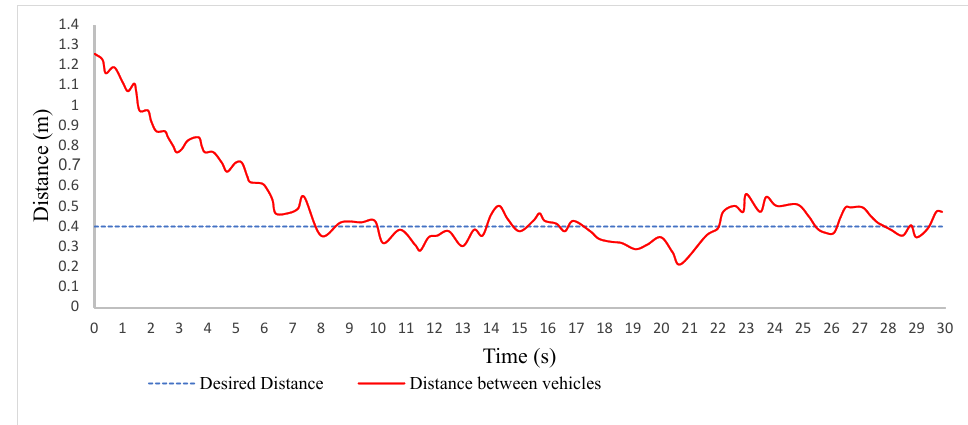
Figure 4. Distance between vehicles vs. desired distance.